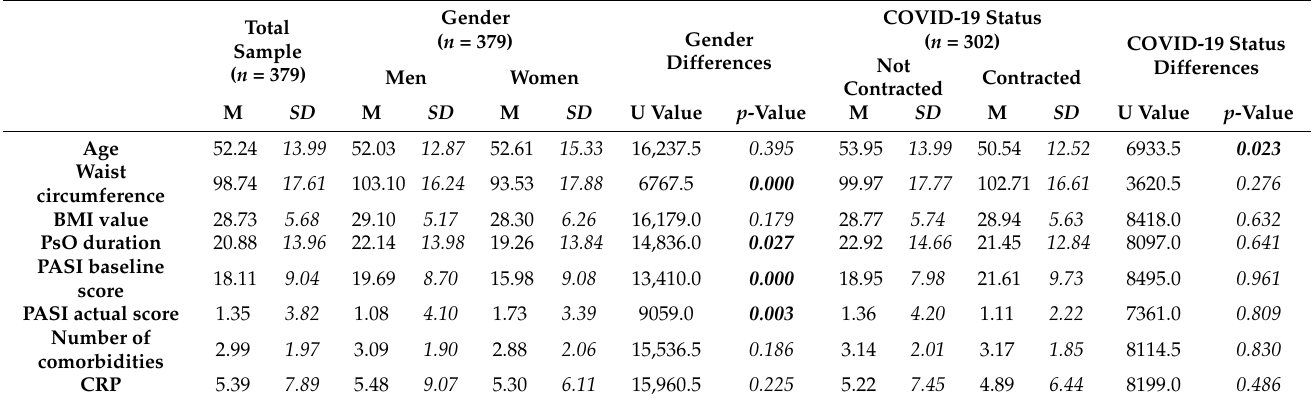
Table 2. Means and standard deviation of the continual variables presented for the total sample, stratified according to gender and COVID-19 contraction; differences tested with Mann–Whitney